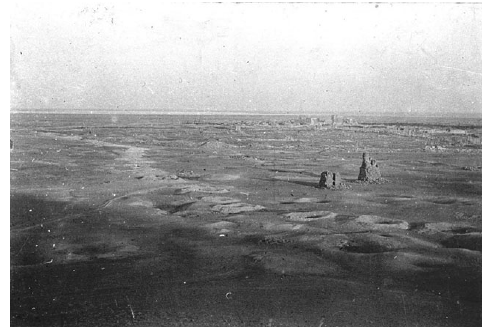
Figure 19. Some ruined tower tombs and looted holes in Palmyra photographed by G. Bell in 1900